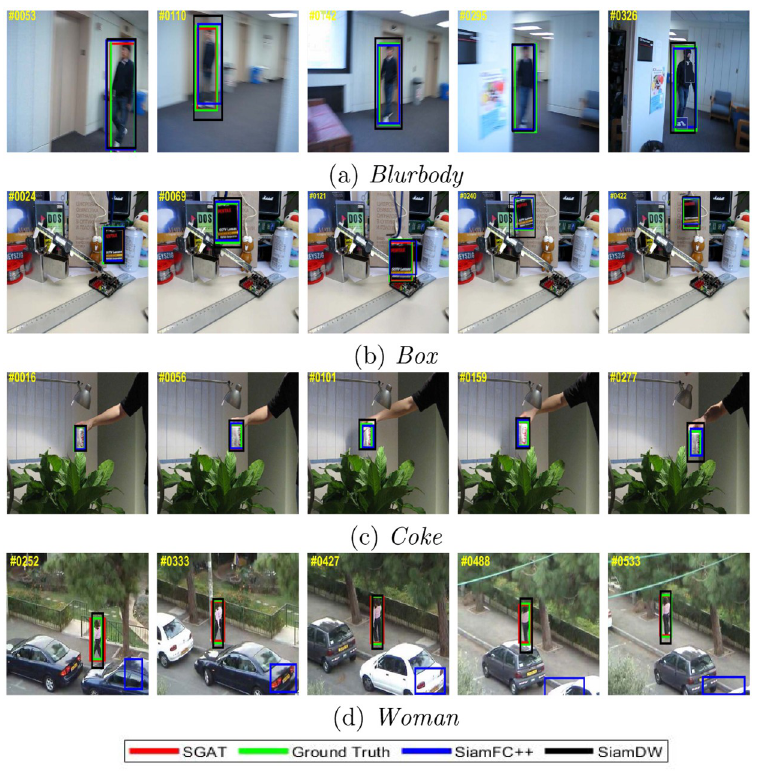
Fig 8. Qualitative results on four challenging sequences with other state-of-the-art trackers.